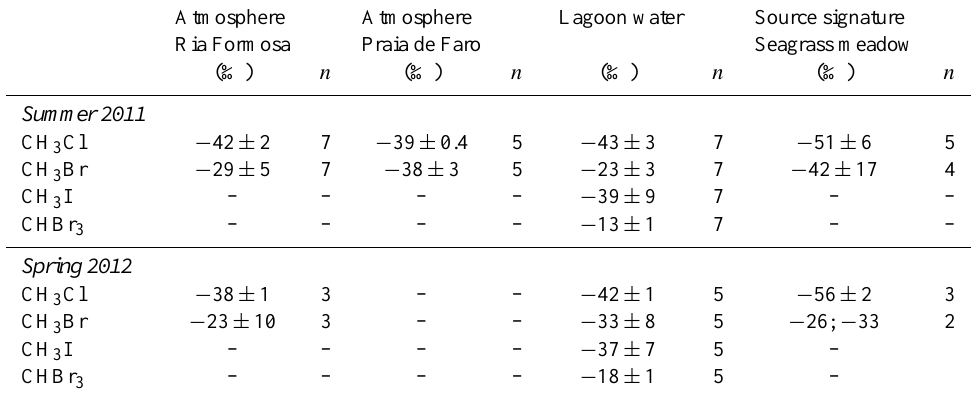
Table 4. Compilation of stable carbon isotope values of halocarbons (%) from the two sampling campaigns. Source signatures of seagrass meadows were calculated using a coupled mass and isotope balance (Weinberg et al.,